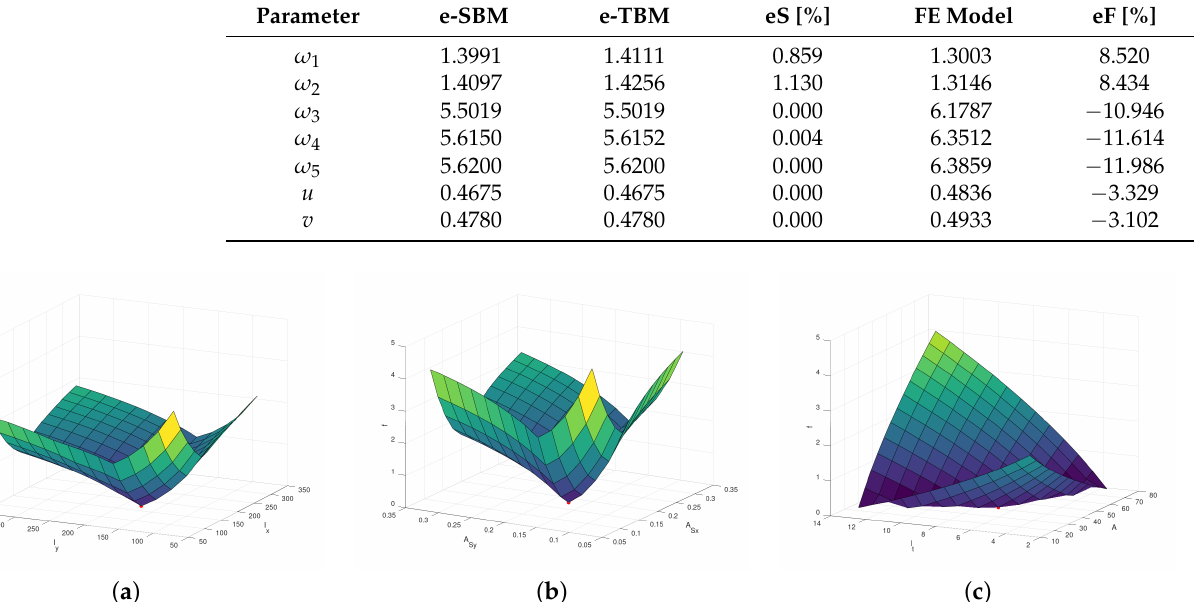
Figure 3. Sensitivity analysis and minimum at the optimal design parameters: second inertia moments, I x and I y , ( a ), shear areas, A s , x and A s , y , ( b ) and cross-section area and torsional stiffness, A and I t ( c